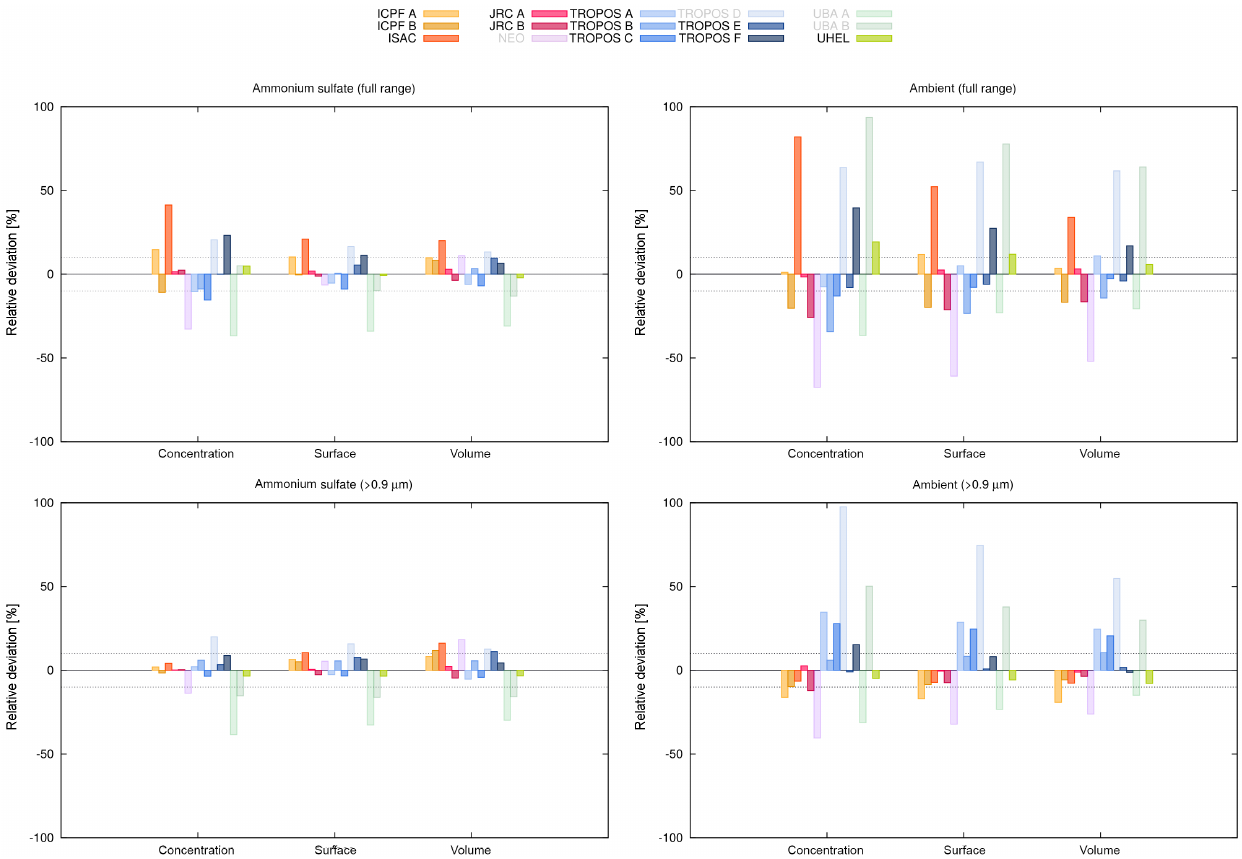
Figure 5. Relative deviation of the calculated total number, surface and volume concentration for the measured distribution relative to the averaged distribution: ammonium sulfate (left column) and ambient aerosol (right column), full size range (upper row) and for particles larger 0.9µm (lower